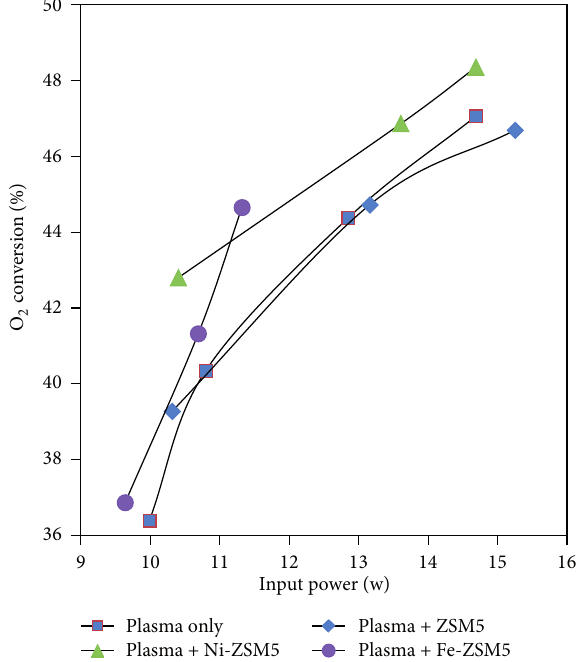
F 2: Methane conversion versus power consumed in the reactor. F3:Oxygenconversionversuspowerconsumedinthereactor.